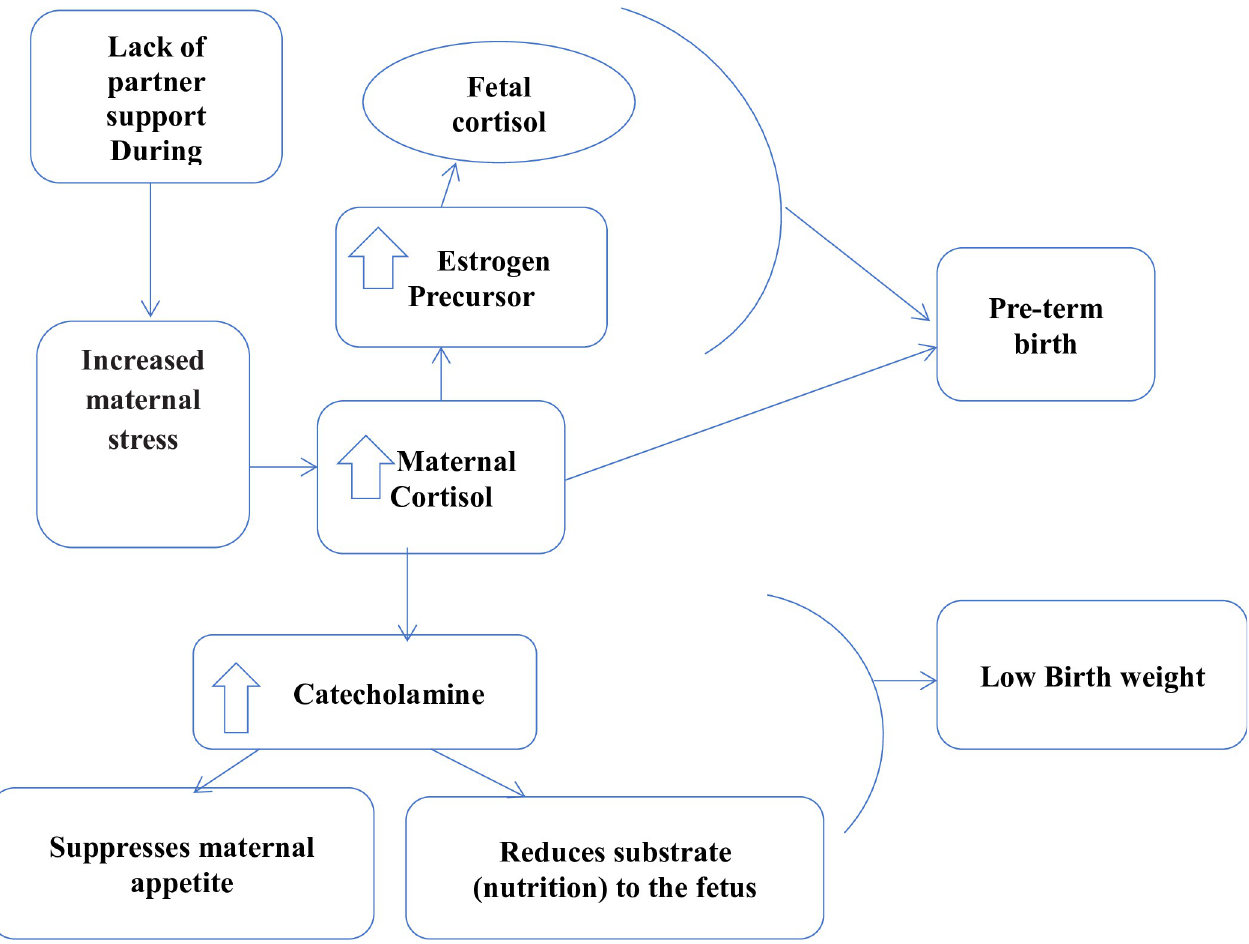
Fig 1. Mechanisms and pathways of male involvement to birth outcome adapted from literature